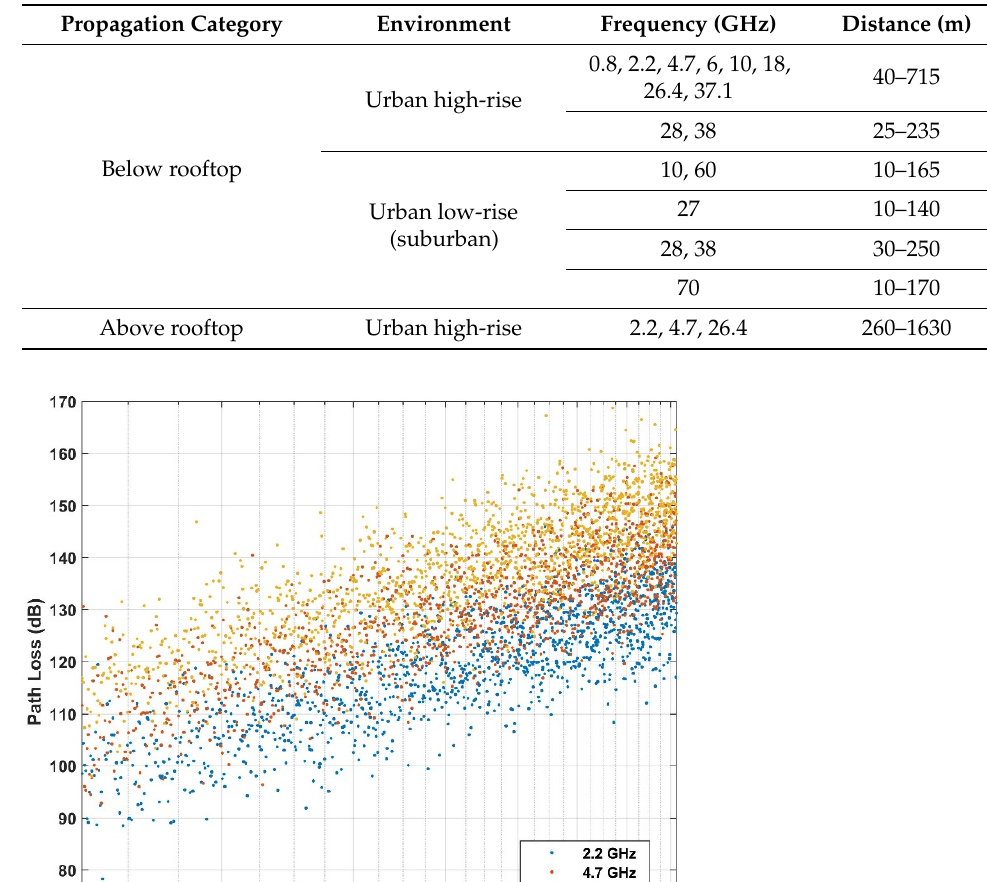
Figure 2. Empirical path loss at an above rooftop in an urban high-rise environment.